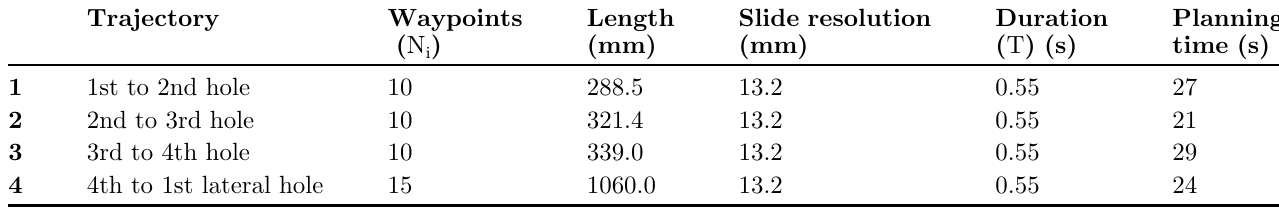
Table 3. DP solver parameters for trajectories 1 – 4. Planning times are related to the execution of the algorithm on a virtual machine with a single-threaded implementation.